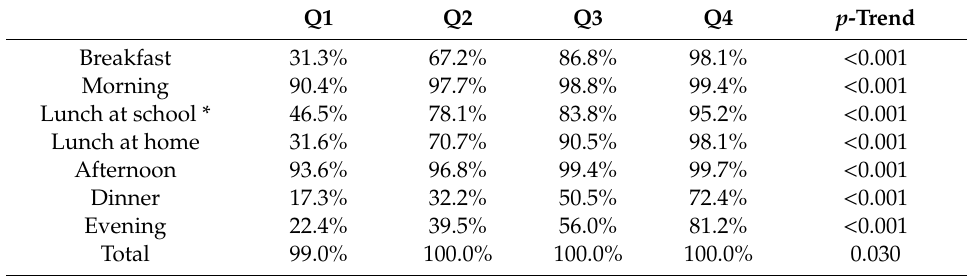
Table 4. Percentages of children consuming SSBs at di ff erent time segments, over the 4 quartiles of SSB intake. Q1 Q2 Q3 Q4 p -Trend Breakfast 31.3% 67.2% 86.8% < 0.001 90.4%